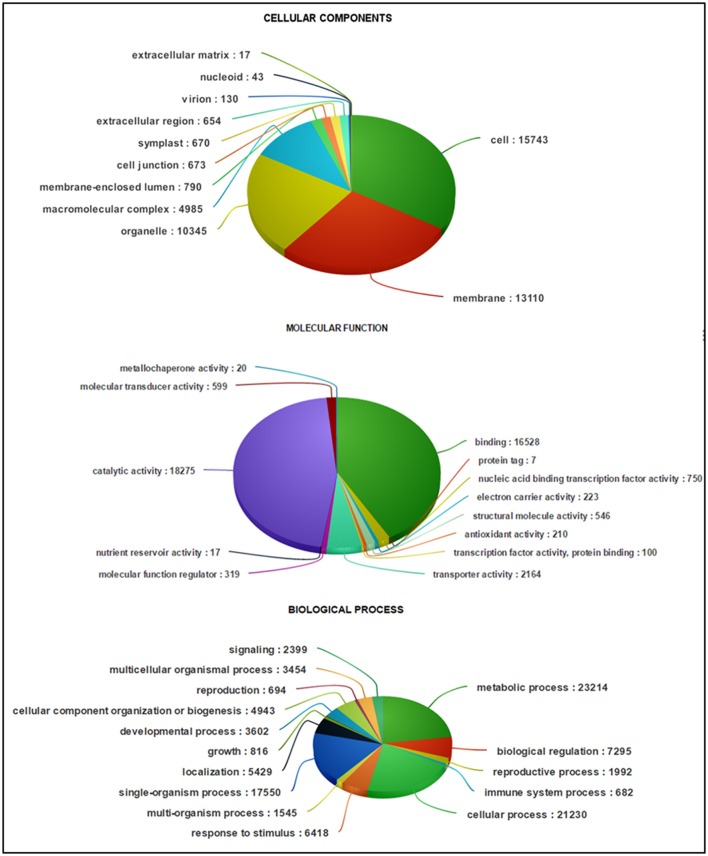
Classification of guar leaf transcripts into functional categories according to GO-terms.